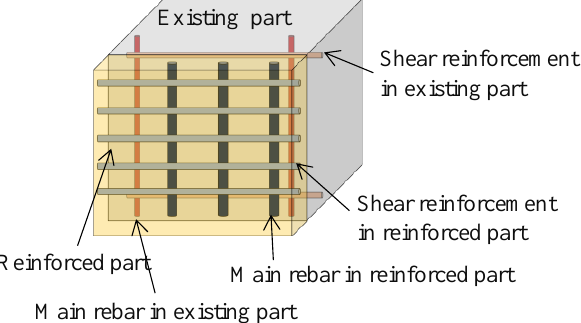
Figure 3. Modeling of reinforcement part in bird’s-eye view.